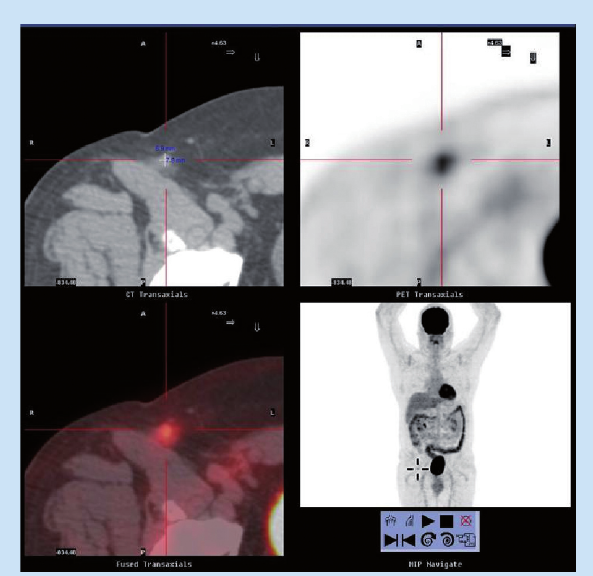
Fig. 2. Enlargement of the images above, with the measurements of the lymph node displayed (6.9 mm x 7.9